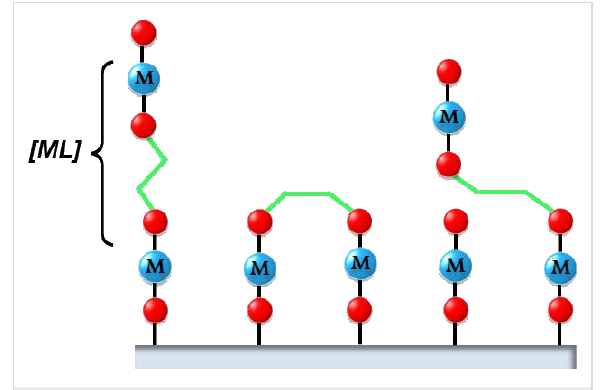
Figure 5: Ideally, the organic precursor molecule reacts with one surface site only and remains straight (left). It may also react twice with the surface (middle) or tilt